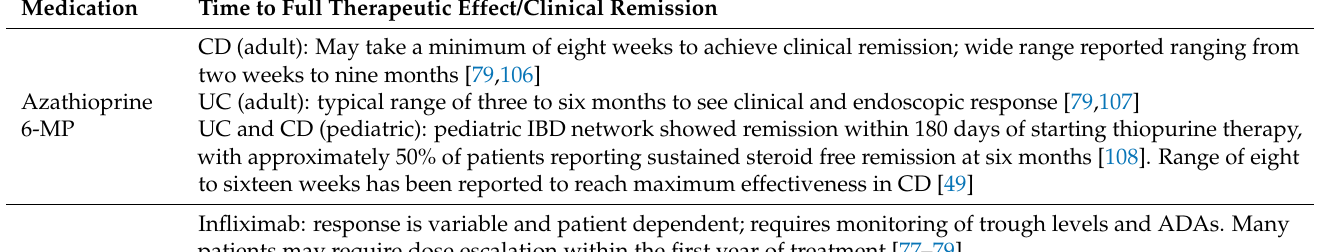
Table 4. Time to Therapeutic Effect for Immune-Targeted